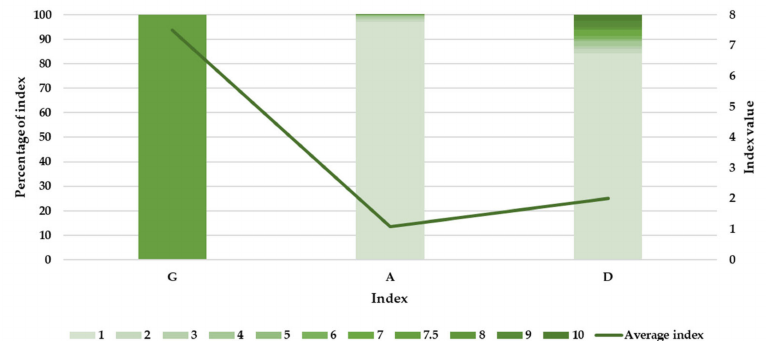
Figure 4. Distribution of static parameters’ ratings for groundwater occurrence (G), aquifer hydraulic conductivity (A), and distance from the shore (D).